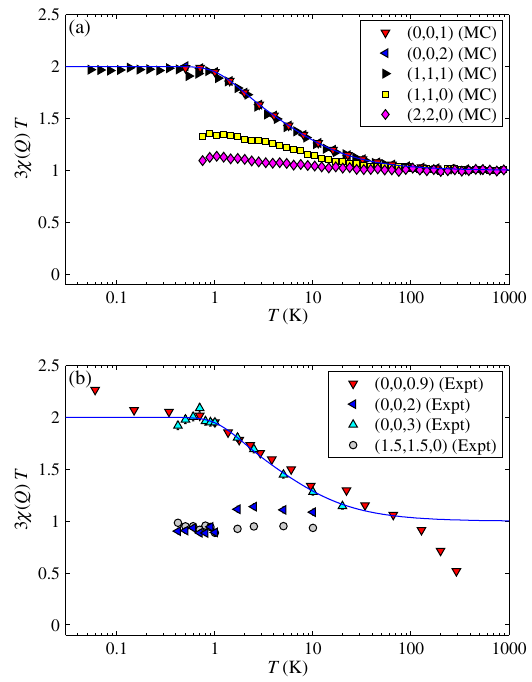
FIG. 6. Wave-vector-dependent susceptibility compared to theory. Panel (a): Simulations of the NNSI model at selected Q points, obtained from Monte Carlo simulation. Panel (b): Temperature dependence of S ð Q ; T Þ measured for Ho (see text for details), compared with